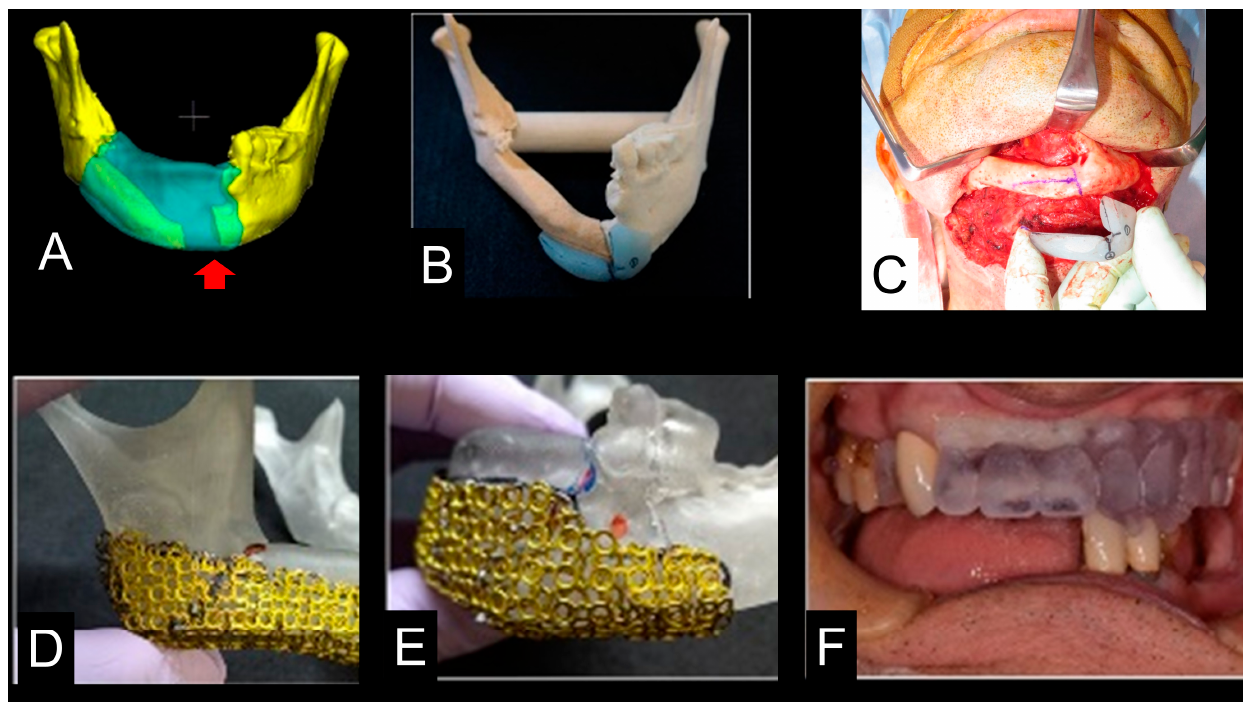
Figure 2 . Virtual mandibular reconstruction (Case 11) suggested the cutting points of the mandible (arrow) ( A ). The 3D model was made and the cutting device showed the cutting points ( B ). Clinical application of cutting device ( C ). Titanium mesh was made using double-layer titanium mesh via titanium laser welding with anatomical landmarks ( D , E ). Additionally, the occlusal splint was made for accurate occlusal stabilization ( F ).